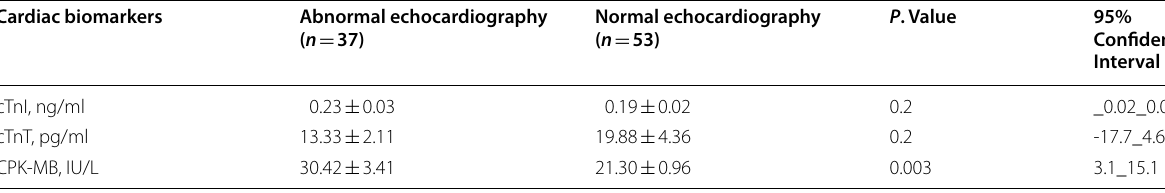
Table 4 Comparison of cTnI, cTnT and CPK‑MB in patients with abnormal vs. normal echocardiography